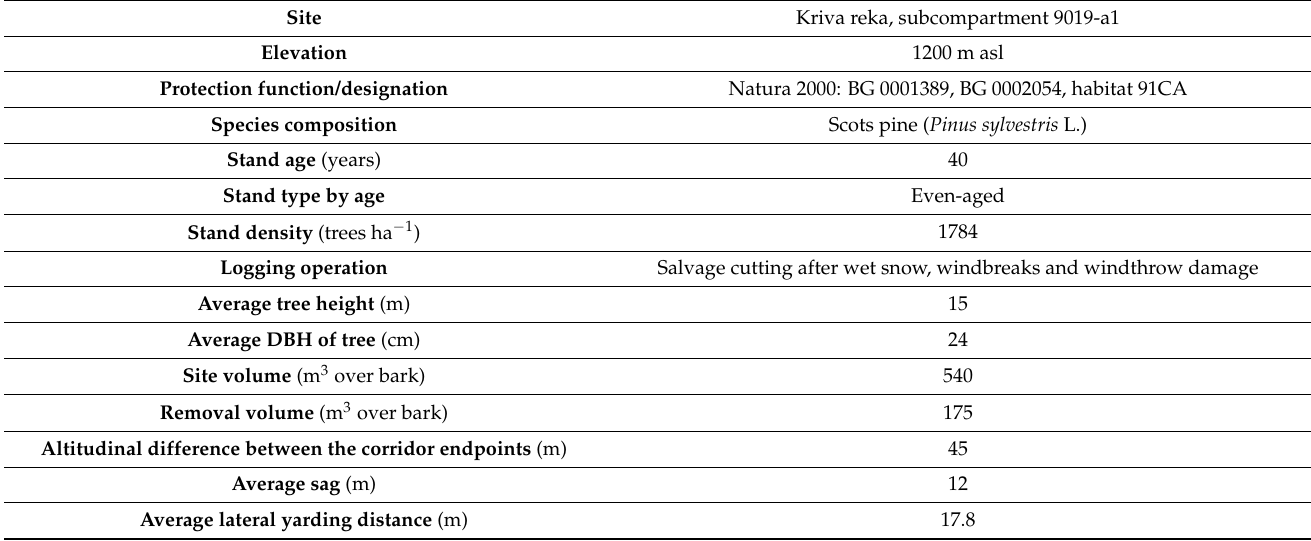
Table 1. Characteristics of the test